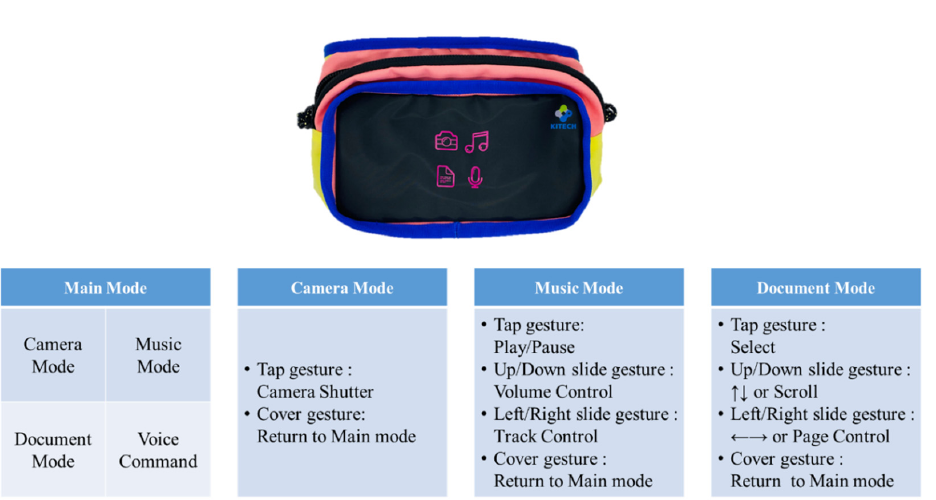
Figure 8. Prototype bag including a touchpad with conductive nonwoven fabric and function of each gesture in each mode.